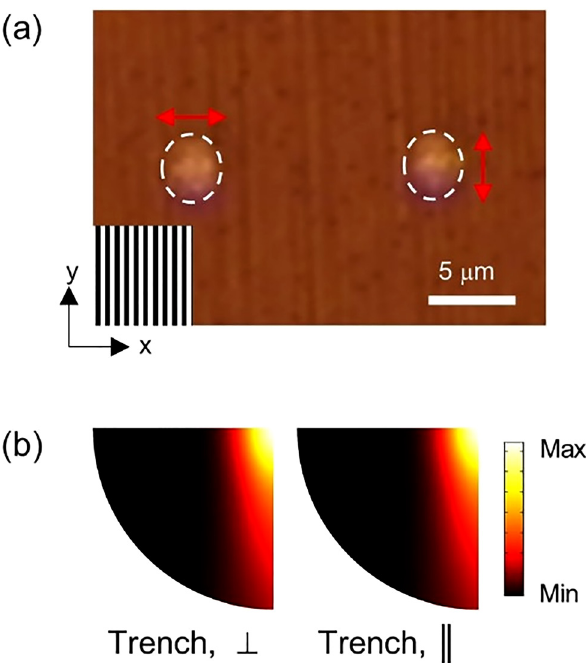
Figure 4: (a) Optical microscope image of the trench after creating damages with the 785 nm laser at perpendicular and parallel polarizations. The trench direction was aligned to the x -axis. The boundaries of the damages are marked by white dashed lines. The inset shows the direction of the trench, and red arrows show the polarization directions. (b) Numerically simulated surface temperature pro fi les for trench ( ⊥ ) and trench ( || ) showing one- fourth of the heated areas. In the simulations, the nanostructured layers were modeled as effective media, as described in the main text. Each color map is normalized by its maximum value, and the minimum temperatures are 293 K for both maps. The radii of the color maps are 2 μ